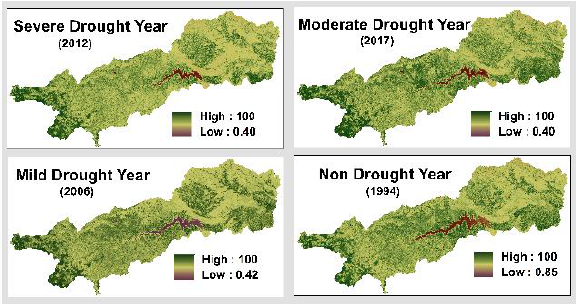
Figure 4. Variation in vegetation conditions index under different drought intensity and non-drought conditions.